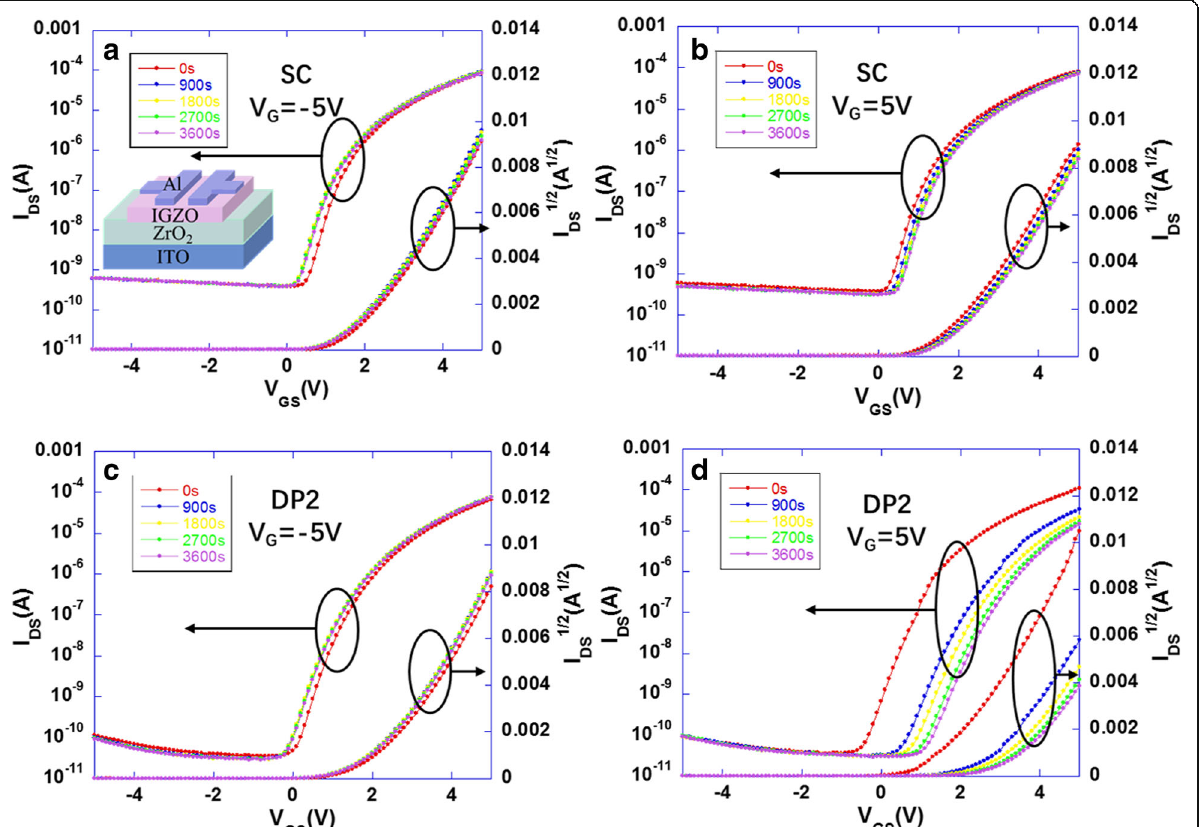
Fig. 5 a NBS and b PBS results of SC-ZrO 2 IGZO TFT. c NBS and d PBS results of DP2-ZrO 2 IGZO TFT